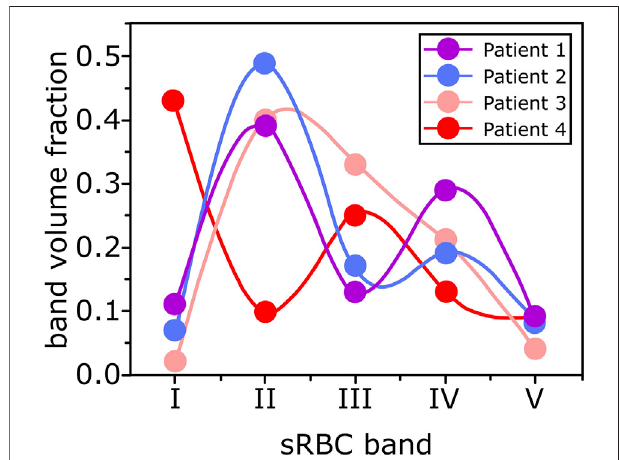
FIGURE 1 | Each dot corresponds to a sRBC band volume fraction (V B / V, where V B is the sRBC band volume and V is the total volume of sRBC) for each patients ’ blood sample. The curves are